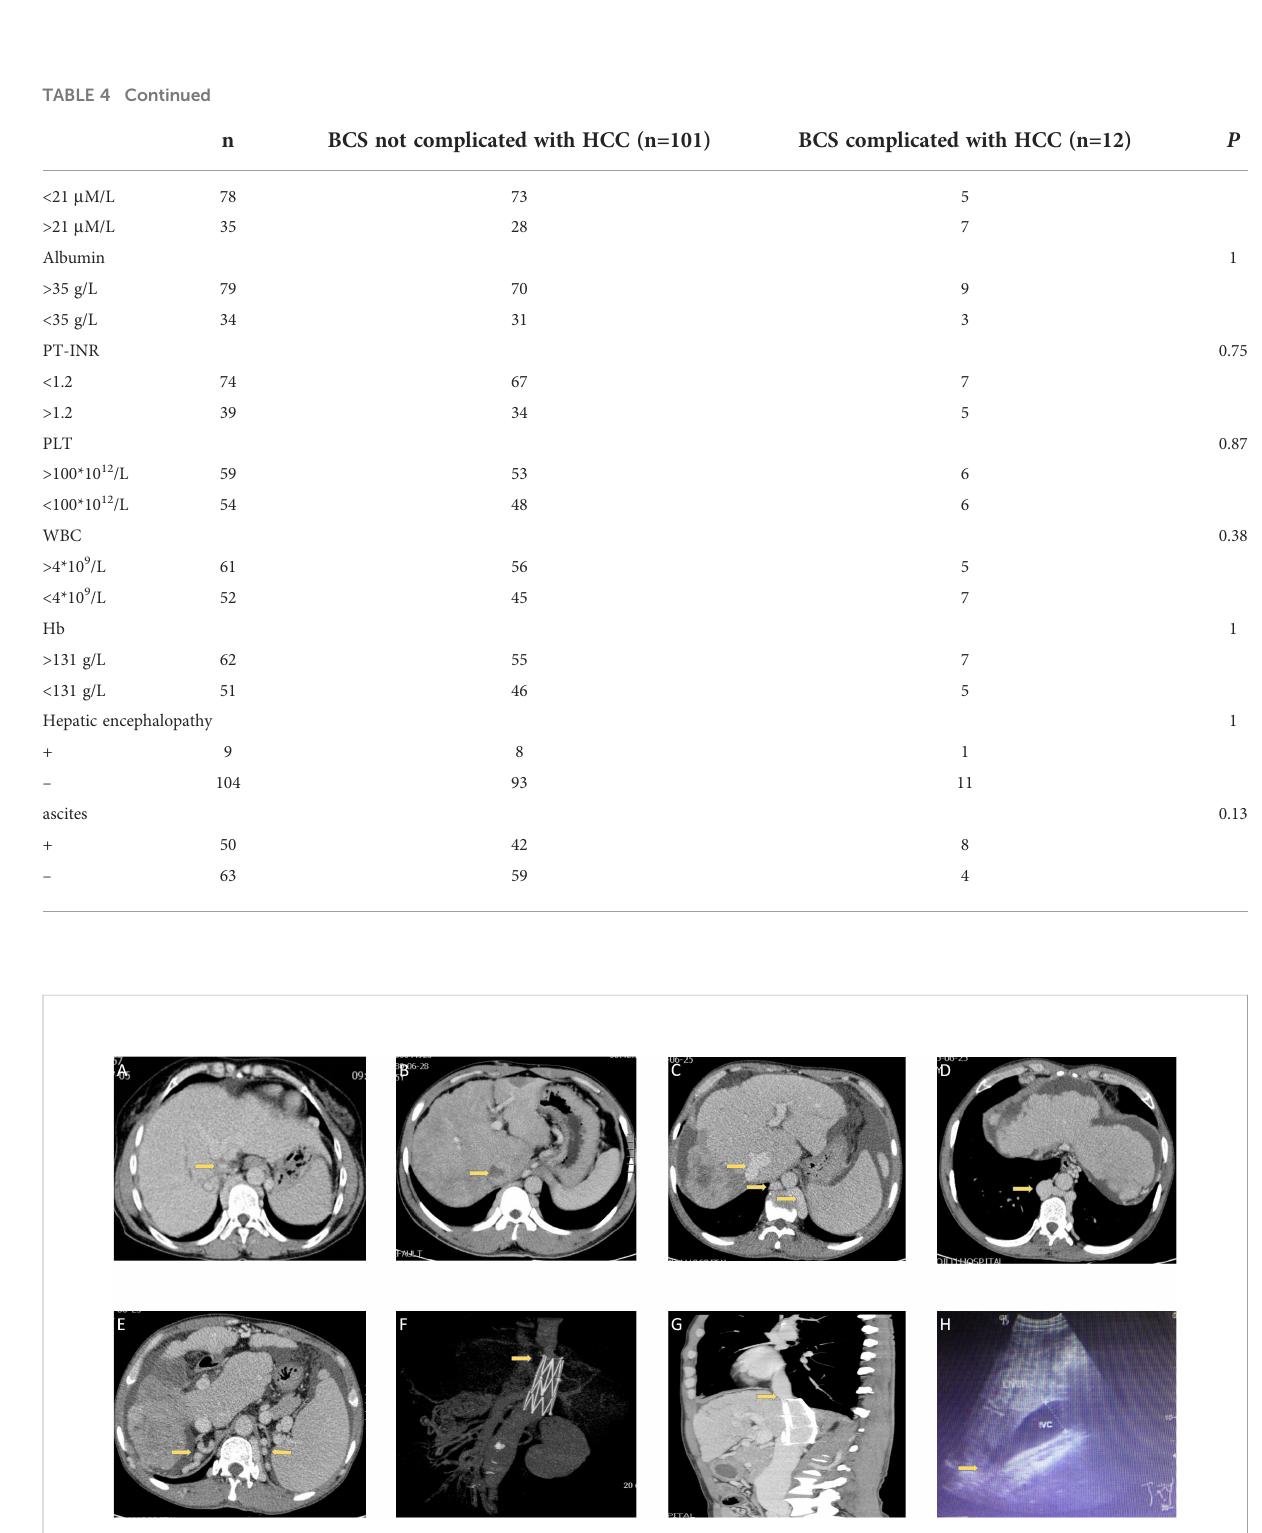
FIGURE 1 Different kinds of obstructions in BCS patients are complicated with HCC. (A) The narrowness of IVC in one patient. (B) Thrombosis in one patient. (C, D) IVC vascular malformation in one patient. (E) Compensatory vascular varicosity in one patient with no signs and symptoms. (F, G) CT angiography and a coronal section showing the segmental obstruction of IVC and corrected by stenting in one patient. (H) Ultrasonic imaging in one